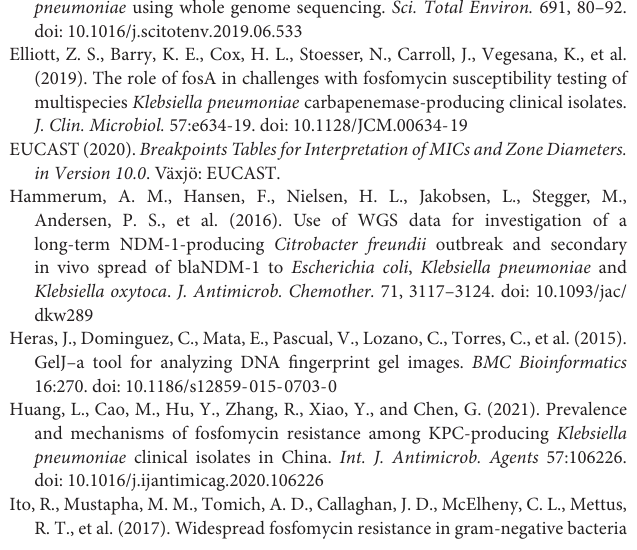
Supplementary Figure 1 | Comparison of genetic environments of the fosA . (A) The genetic environment of fosA kp and foskp96 ; (B) The genetic environment of fosA2 ; (C) The genetic environment of fosA3